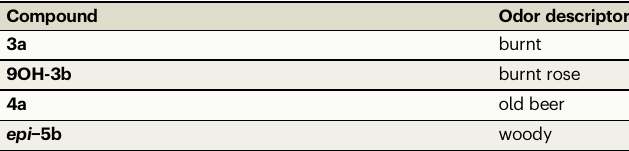
Table 1 | Odor descriptors of main odor-active C 16 terpenes